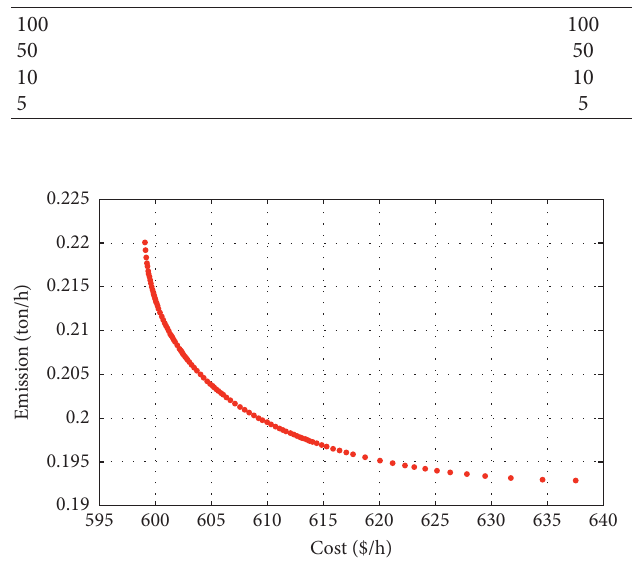
Figure 8: Compromising 100 alternatives from the Pareto